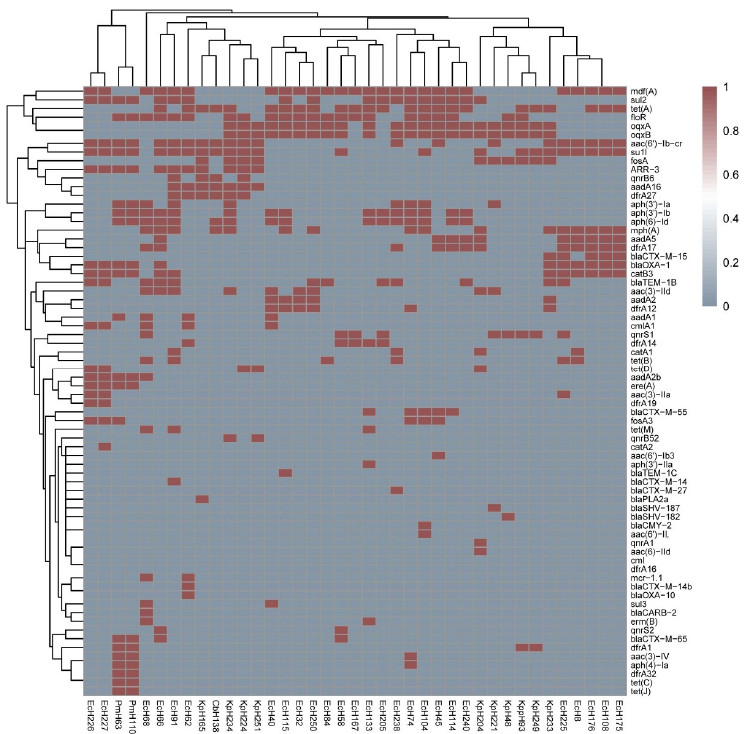
Figure 2. Heatmap showing the diversity profiles of drug resistance genes in the 39 PMQR gene- positive isolates. Table 2. Characteristics of PMQR and other resistance genes in the plasmids of the Enterobacteriaceae isolates. Table 3. Concordance rate between drug resistance genes and drug resistance